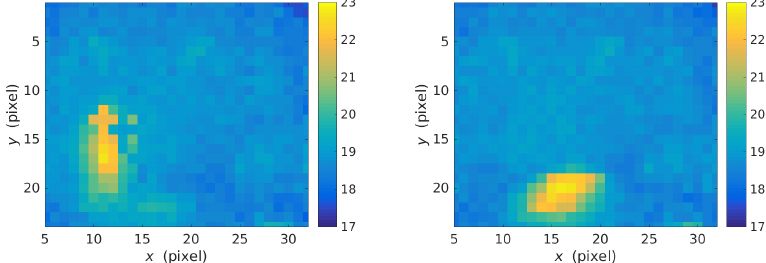
Figure 1. Heat maps of two 32 × 24 frames generated by the Melexis MLX90640 sensor for a standing body (left) and a fallen body